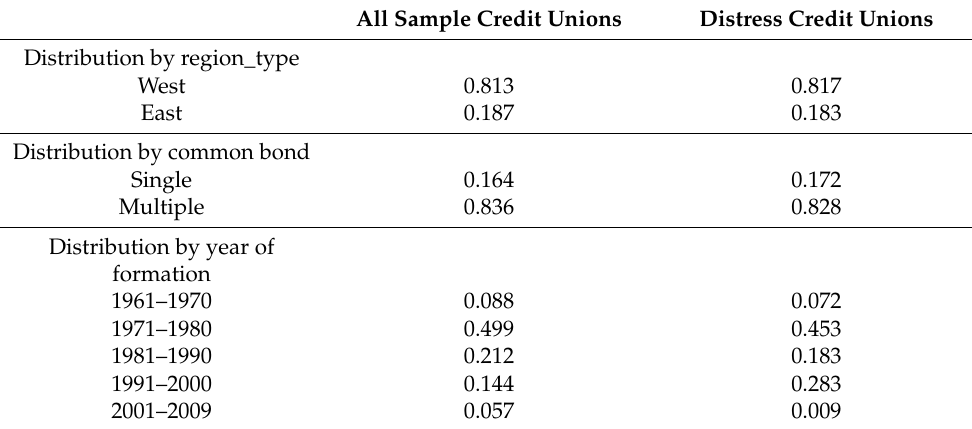
Table 3. Summary Statistics: Non-time-varying covariates from